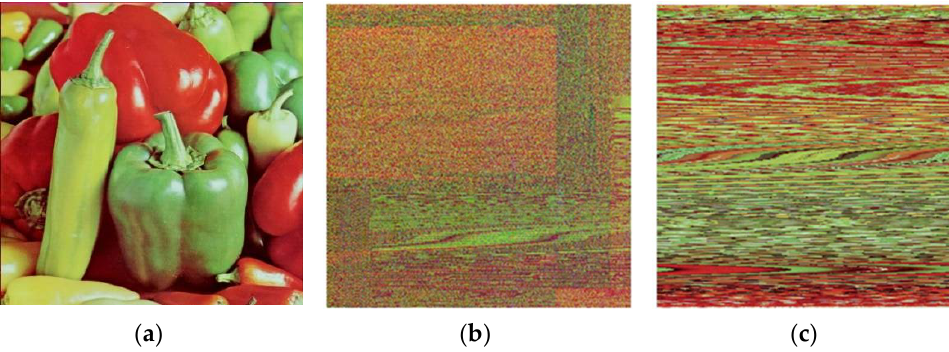
Figure 7. Permuted images using two different Zigzag transformations: ( a ) Peppers; ( b ) dynamic block Zigzag transformation; ( c ) standard Zigzag transformation. Table 1. Correlation coefficients of neighboring pixels after different Zigzag transformations (The bold part is the relevant value of the proposed algorithm.).